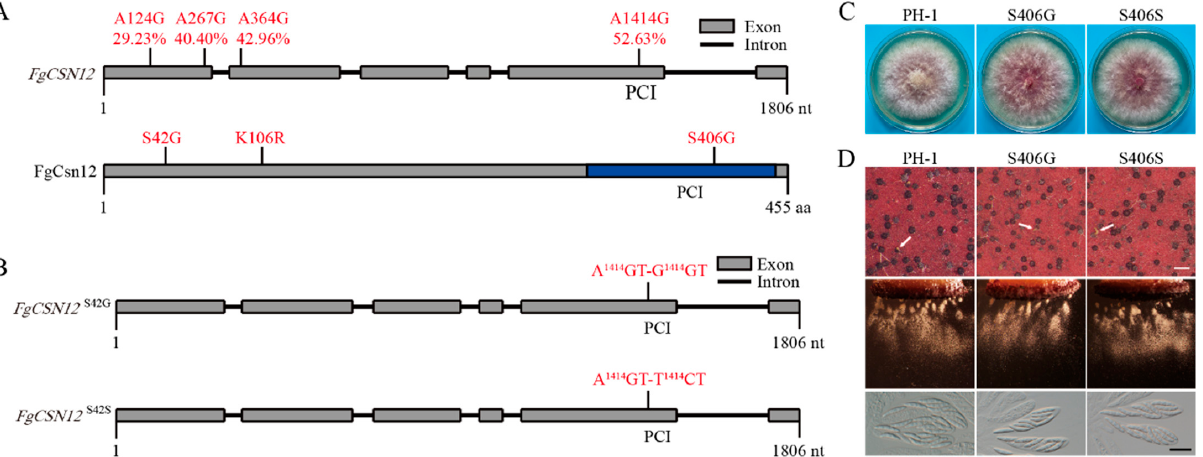
Figure 7. Effects of expressing edited and uneditable alleles of FgCSN12 on sexual reproduction. ( A ) Schematic drawing of FgCSN12 and its protein. The A-to-I RNA editing sites and efficiency are marked in red. The amino acid changes caused by A-to-I RNA editing are also marked in red. The PCI domain is labeled with a blue box. ( B ) Schematic drawing of the FgCSN12 S406G and FgCSN12 S406S mutants. The FgCSN12 S406G mutant had the A 1414 GT to G 1414 GT mutation. The FgCSN12 S406S mutant had the A 1414 GT to T 1414 CT mutation. ( C ) Three-day-old PDA cultures of the wild type (PH-1) and transformants of the Fgcsn12 mutant expressing the FgCSN12 S406G (S406G) and FgCSN12 S406S (S406S) alleles. Photographs were taken after 3 days of incubation. ( D ) Mating cultures of PH-1, S406G, and S406S were examined for perithecium formation (upper), ascospore discharge (middle), and asci with ascospores (lower) in 8 dpf perithecia. White arrows point to cirrhi. White bar = 1 mm; black bar = 20 μ m.